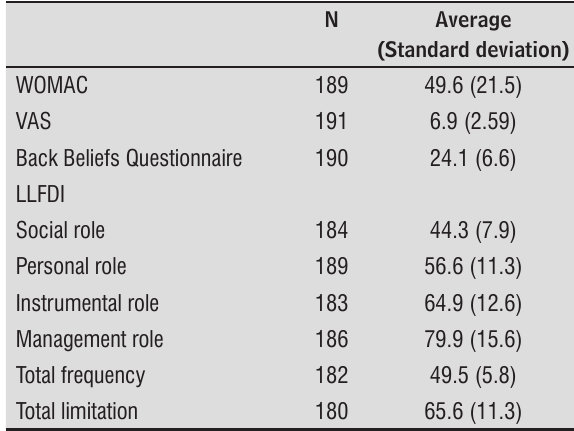
Table 2 - Characterization of the sample of clinical variables, beliefs and functional